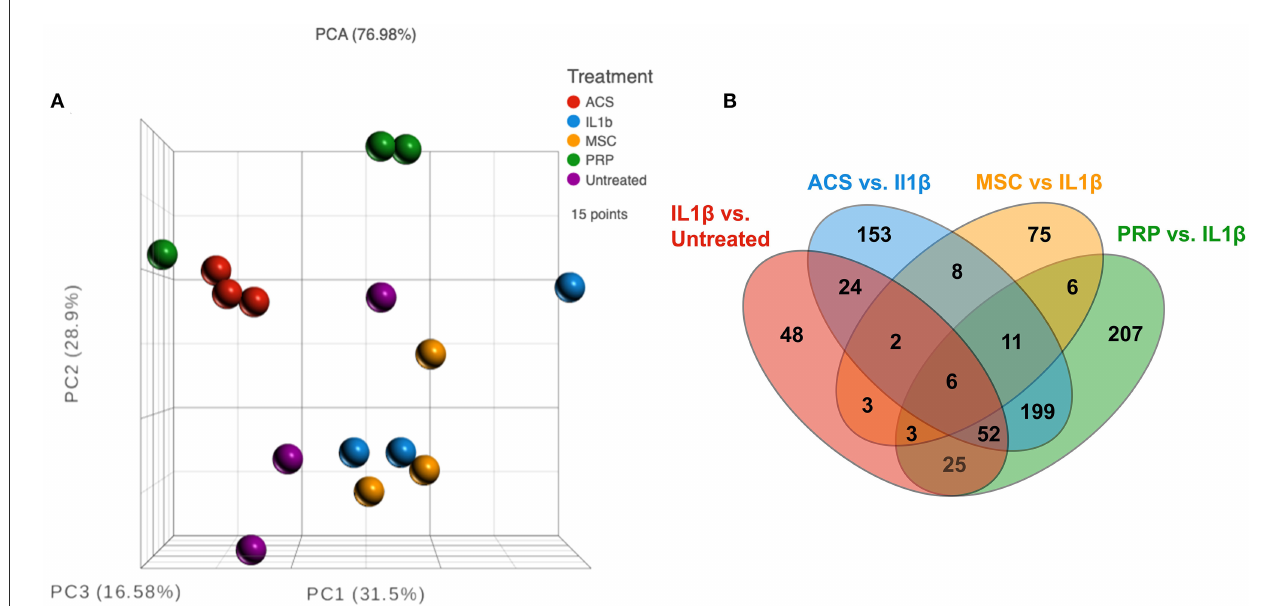
FIGURE3 RNA sequencing analysis comparing three different types of treatment on macrophages. (A) Principle component analysis (PCA) or normalized counts from equine macrophages. Red dots show n = 3 technical replicate of macrophages treated with IL-1ß only, and purple show technical replicates of untreated macrophage. Other treatments include n = 3 biological replicates of orthobiologics including MSC supernatant (yellow), ACS (blue), and PRP (green), all treatments collected from n = 3 donor horses. (B) Venn diagram of differentially expressed genes from each comparison group, IL1-ß vs. untreated (red), IRAP vs. IL-1ß (blue), MSC vs. IL-1ß (yellow) and PRP vs. IL-1 ß (green). All comparisons except MSC were filtered by FDR adjusted p value of 0.05, MSC groups filtered using unadjusted p value of